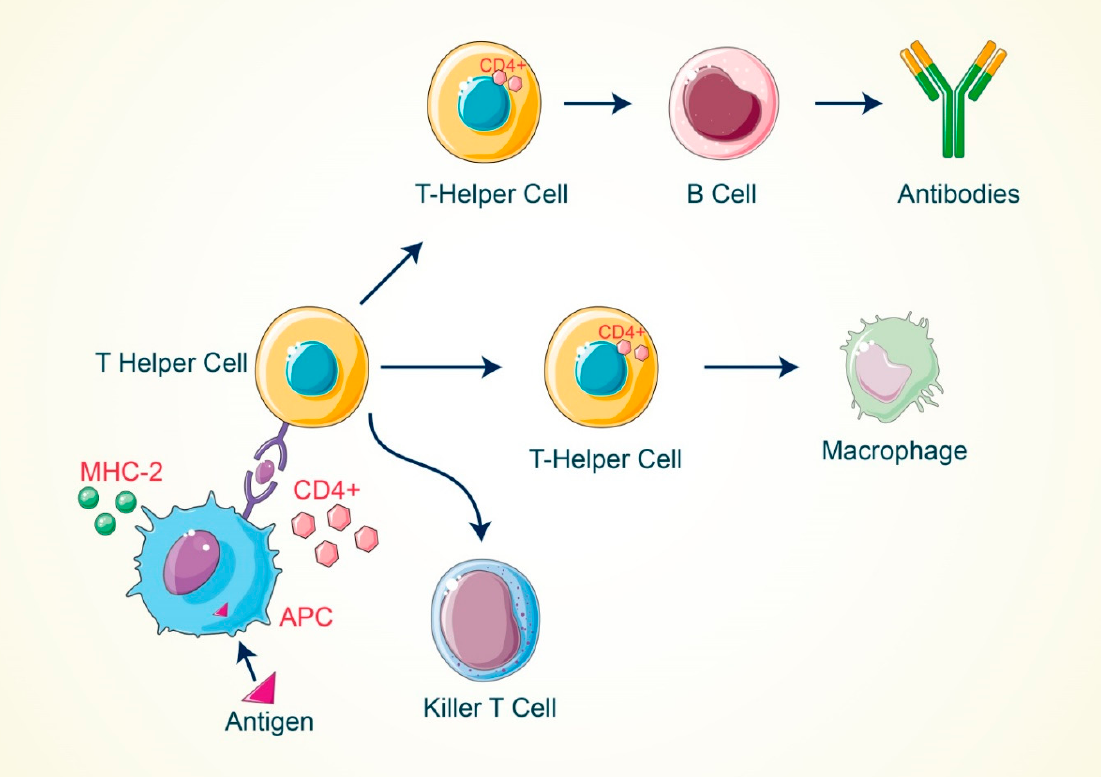
Figure 1. Diagrammatic recognition process of cancer antigens via T cells. APC directly recognize the cancerous antigens on the surface on rapidly proliferative cells and activate signal phase-1. Fol- lowing, signal phase-2 is activated by attaching the MHC-II with T-cell receptors and activating the T